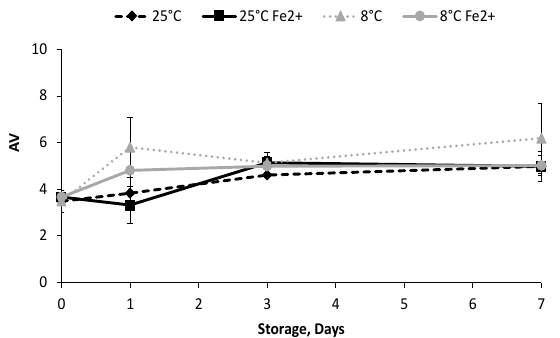
Figure 5. Peroxide value (PV) ( a ) and anisidine value (AV) ( b ) of multiple emulsions in a seven day-storage period at 25 °C and 8 °C in the dark.